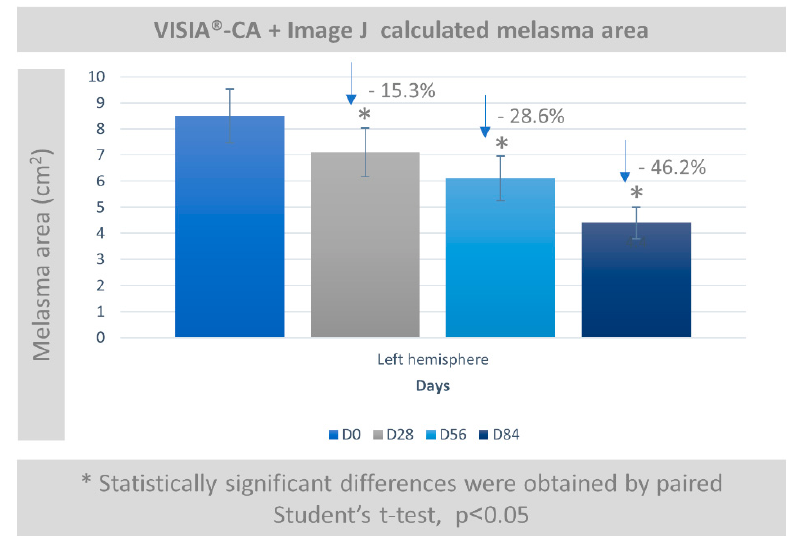
Figure 4. Melasma area (cm 2 ) in left hemisphere obtained by analysis of images by Image J software.